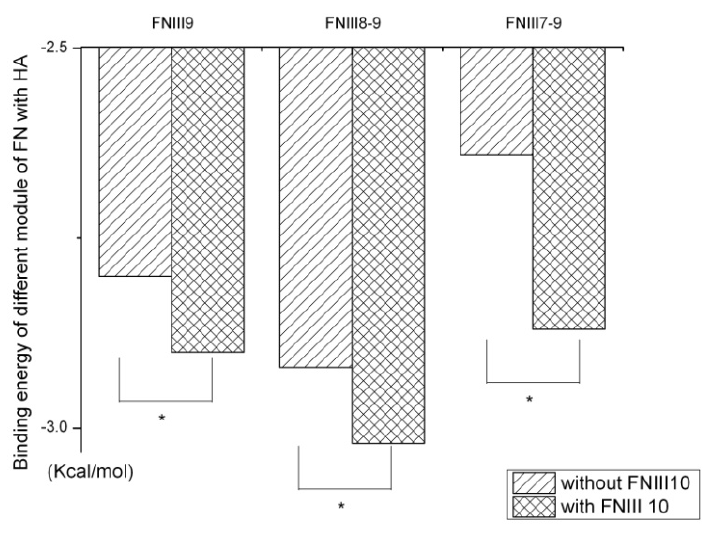
Figure 4. The lowest binding energy between different modules of FN-III nanoparticle. Without FNIII , the binding energy between other different modules of 10 FNIII and their combinations will be reduced 7–9